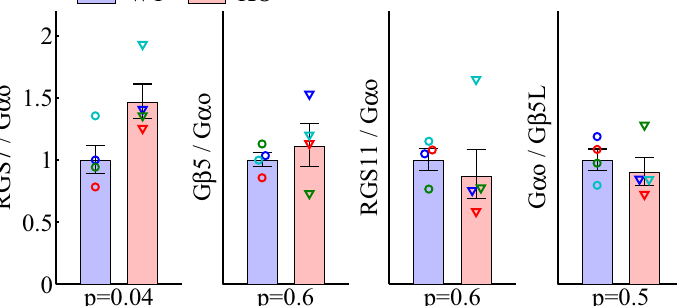
Figure 6. RGS7 is the driving force of increased RGS7-G β 5 levels in Ate1 knockout retinas. ( A ) A scatter plot of the paired KO/WT ratio of RGS7 versus G β 5 protein levels demonstrates a positive correlation for OPL, rOBC, and cOBC (Pearson/ Spearman correlation coefficient=0.68/0.77, 0.44/0.49, and 0.54/0.55; with p-value=0.007/0.001, 0.11/0.08, and 0.04/0.05; respectively. n=14 pairs each). ( B ) A scatter plot of the KO/WT ratio of RGS11 versus G β 5 protein levels shows that there is no correlation for any of OPL, rOBC, and cOBC (Pearson/Spearman correlation coefficient=0.22/0.28, –0.10/–0.08, and 0.007/0.19; with p-value=0.44/0.33, 0.72/0.79, and 0.98/0.51; respectively. n = 14 pairs each). ( C , top) Representative Western blots of retinal lysates showing RGS7, G β 5 , RGS11, G α o , and G β 5 L levels in WT and Ate1 KO retinas. ( C , bottom) Western blot quantification of the corresponding proteins relative to GAPDH for 4 WT and 4 KO retinas from 3 litters. Data from each retina is plotted in a unique symbol. Each lane was loaded with the same amount of total proteins from each retina. For RGS7 and RGS11, each data point was the geometric average over 3 blots. ( D ) Quantification of ratios of RGS7, G β 5 , and RGS11 to G α o , and G α o to G β 5 L. All ratios were normalized to WT. RGS7 ratios to G α o increased significantly in Ate1 KO. The error bars represent SEM, the p-values are from Welch’s t-test. Paired Student’s t-test also shows the significant increase of RGS7 (Fig. S5A). To make sure that the difference of RGS7 from the others was not due to Western blot signal saturation, we performed a load test experiment which showed that both RGS7 and GAPDH signals are in the linear range (Fig.